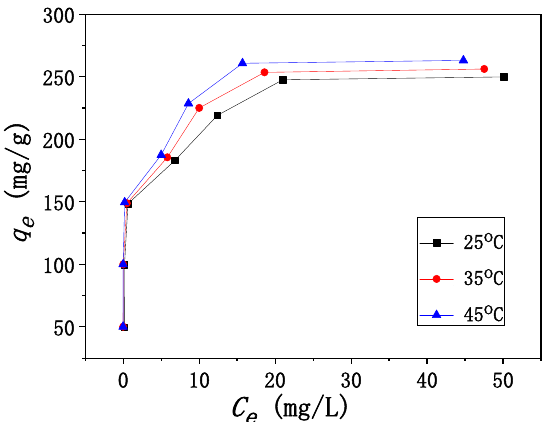
Figure 8. The curves of uranium adsorption by NiCo 2 O 4 /MWCNTs as a function of temperature. pH, 5.0; temperature, 25–45 °C; the mass of adsorbents, 0.01 g.